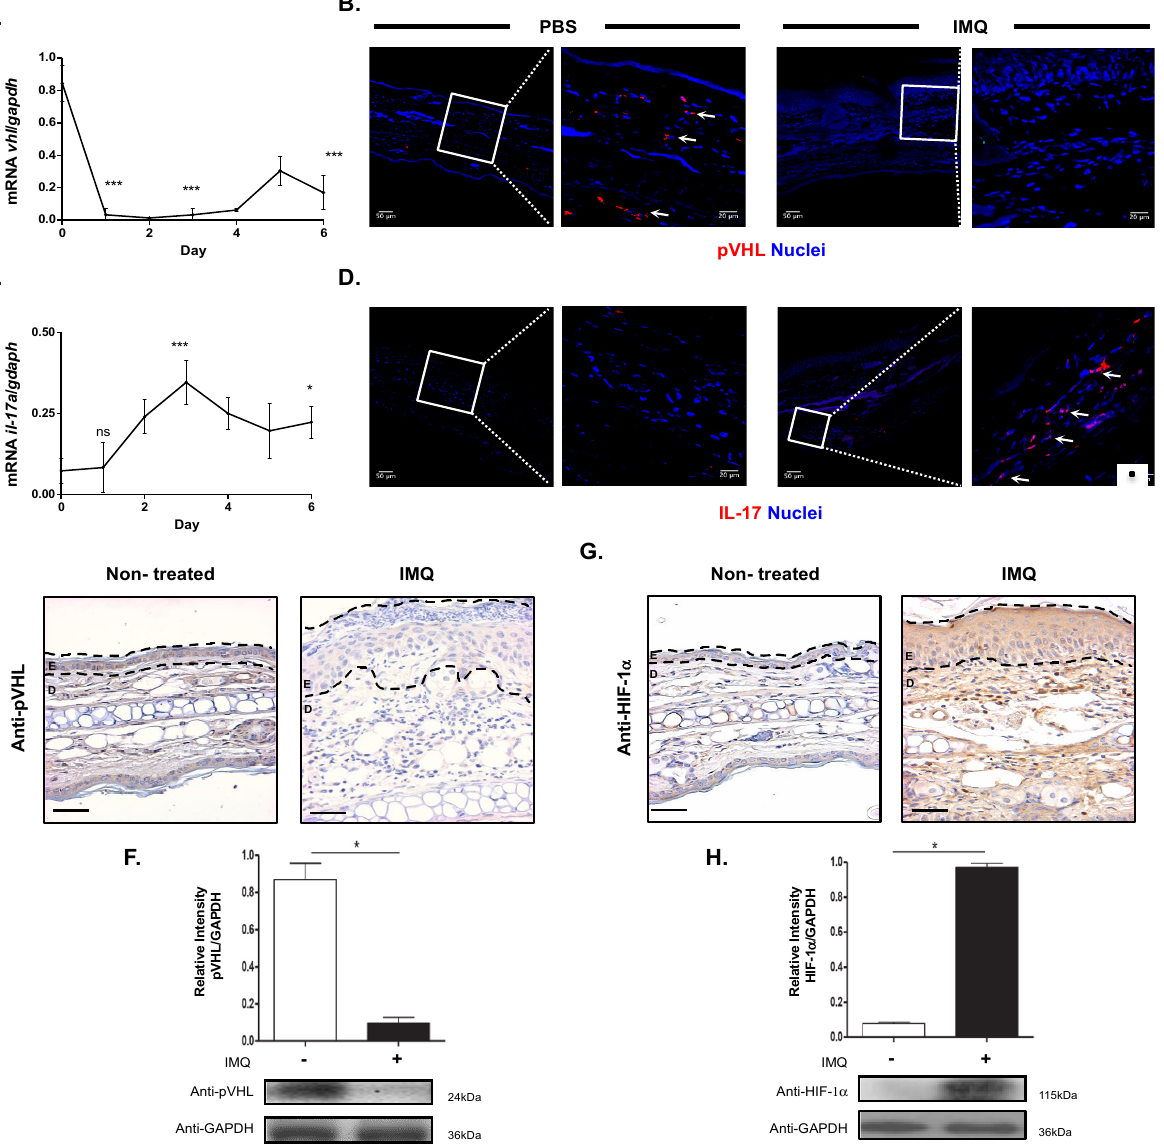
Figure 1. Psoriatic skin from imiquimod-induced psoriasis mice exhibits low presence of pVHL.